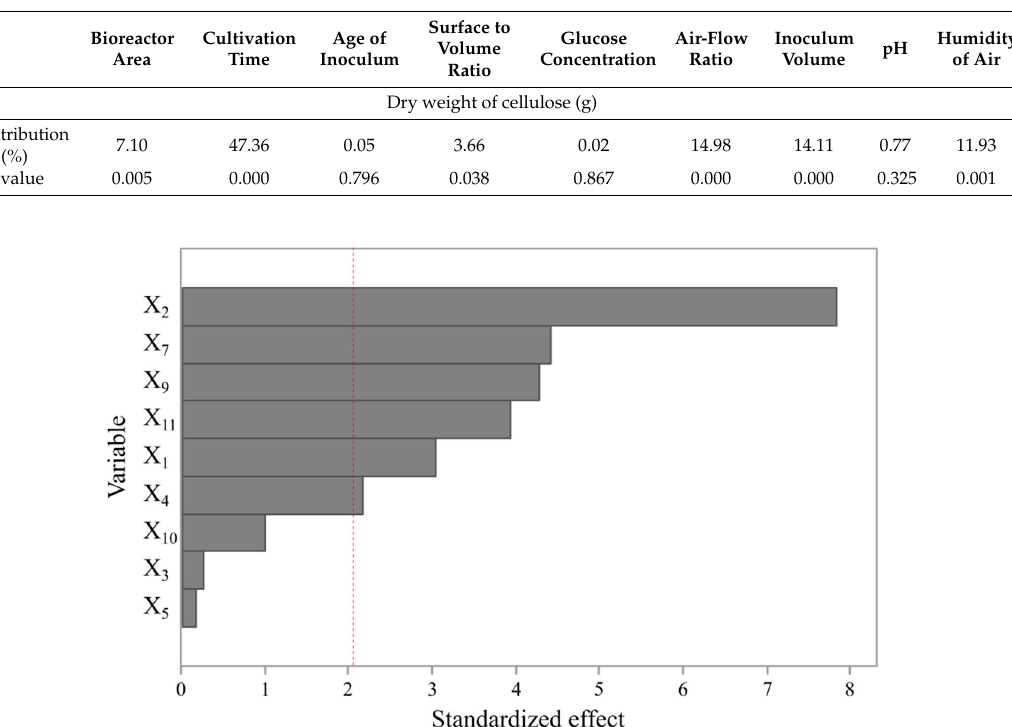
Table A2. Plackett–Burman design % contribution and p -value of the parameters.